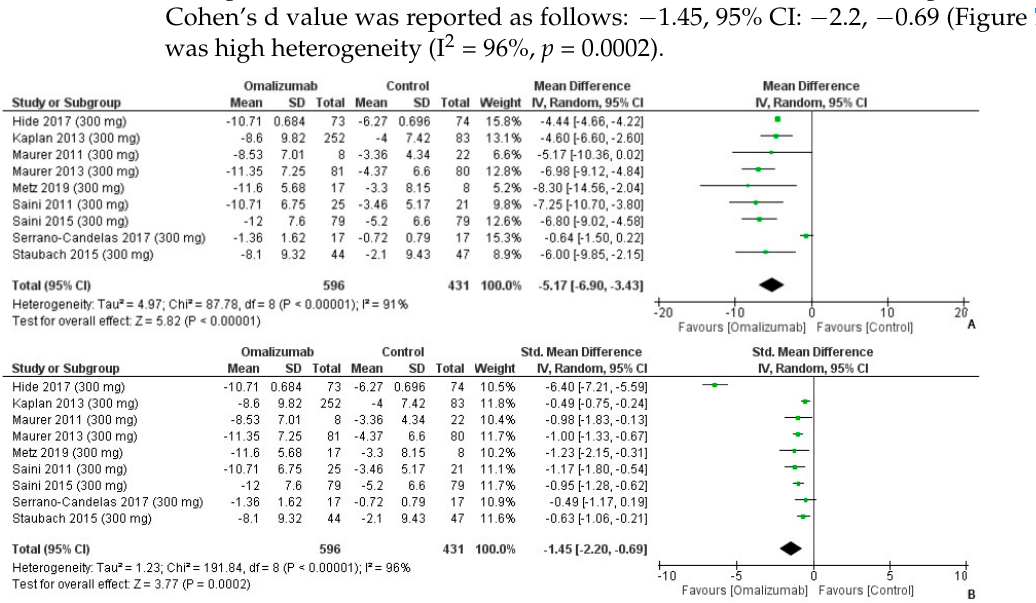
Figure 7. Weekly Wheal Score Outcomes with 300 mg dosage of omalizumab [17–24,26]. ( A ): Mean difference: − 5.17 [95% CI: − 6.90, − 3.43]; Heterogeneity: Tau² = 4.97; Chi² = 87.78, df = 8 ( p < 0.00001); I² = 91%; Test for overall effect: Z = 5.82 ( p < 0.00001) ( B ): Standardized mean difference: − 1.45 [95% CI: − 2.20, − 0.69]; Heterogeneity: Tau² = 1.23; Chi² = 191.84, df = 8 ( p < 0.00001); I² = 96%; Test for overall effect: Z = 3.77 ( p = 0.0002).